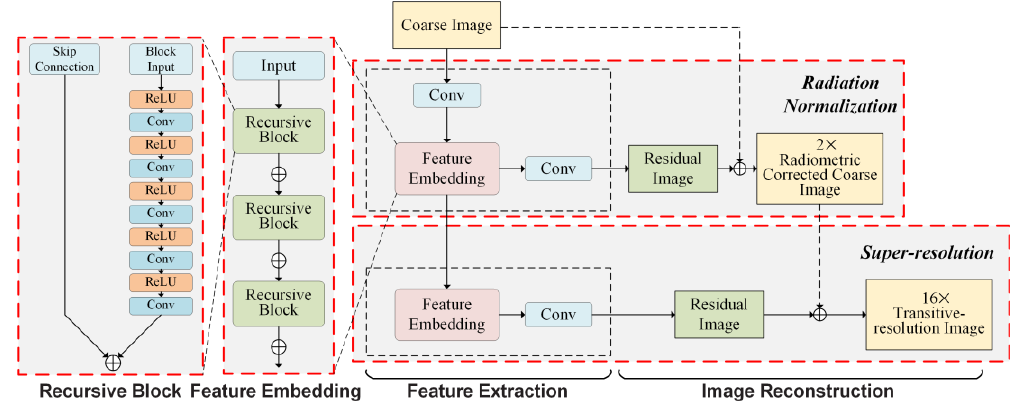
Figure 2. Architecture of the Laplacian pyramid SR network (LapSRN) used in the HDLSFM.